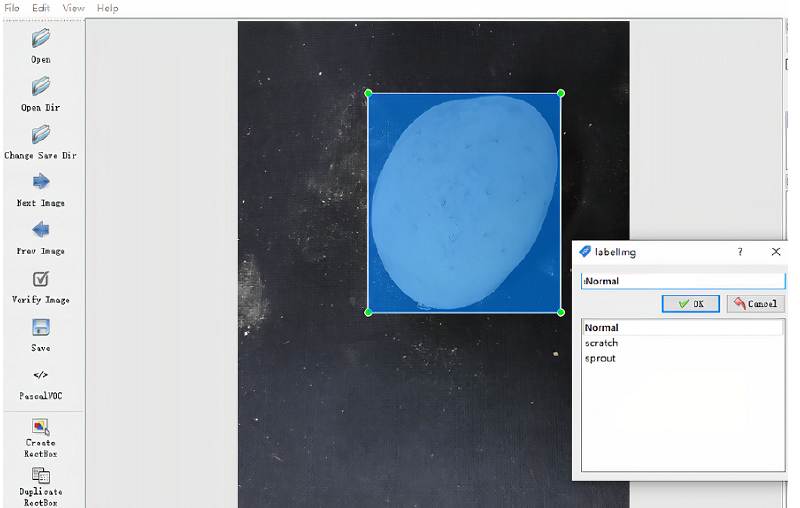
Figure 4. We adopt LabelImg to annotate each potato object in an image by marking a rectangle (i.e., a bounding box) that encompasses the potato object. The coordinates of the bounding box’s four corners specify the location of the marked potato and are used as labels in